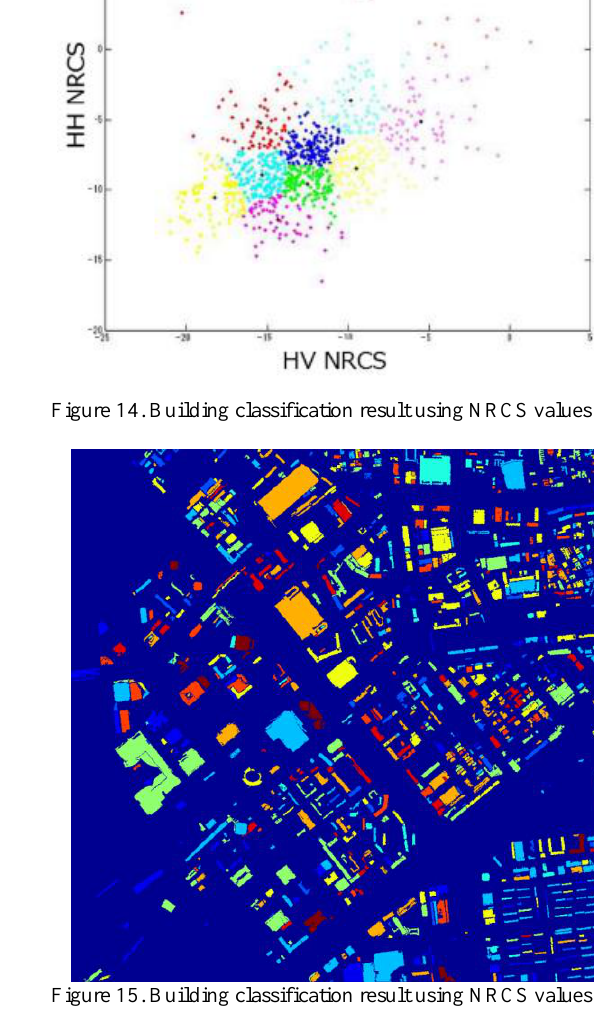
Figure 15. Building classification result using NRCS values